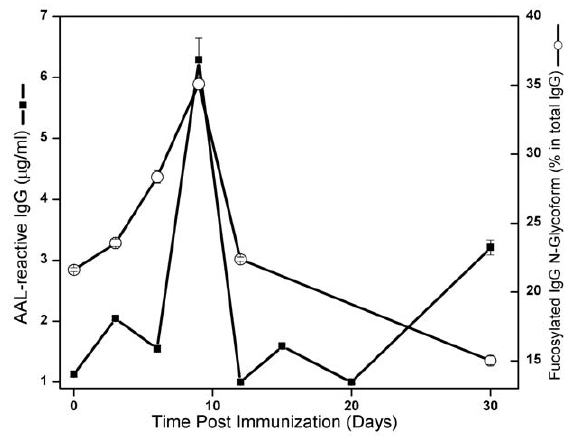
Figure 6. Kinetics curves of fucosylated IgGs (solid line with open circles ( # ) corresponding to the right Y-axis), which were measured by using mass spectrometry, and AAL-reactive IgGs (solid line with solid squares ( & ) corresponding to the left Y- axis), which were measured by using AAL antibody microarray, in serum samples from rabbit 4 which was inoculated with KIN/ CFA. The total fucosylated serum IgG levels were the sum of the percentage of each fucosylated glycoform (as shown in table 2, AAL- reactive IgG column) at each time point. The AAL-reactive IgG levels were measured by using AAL-antibody microarray methods as described in Methods and Materials.